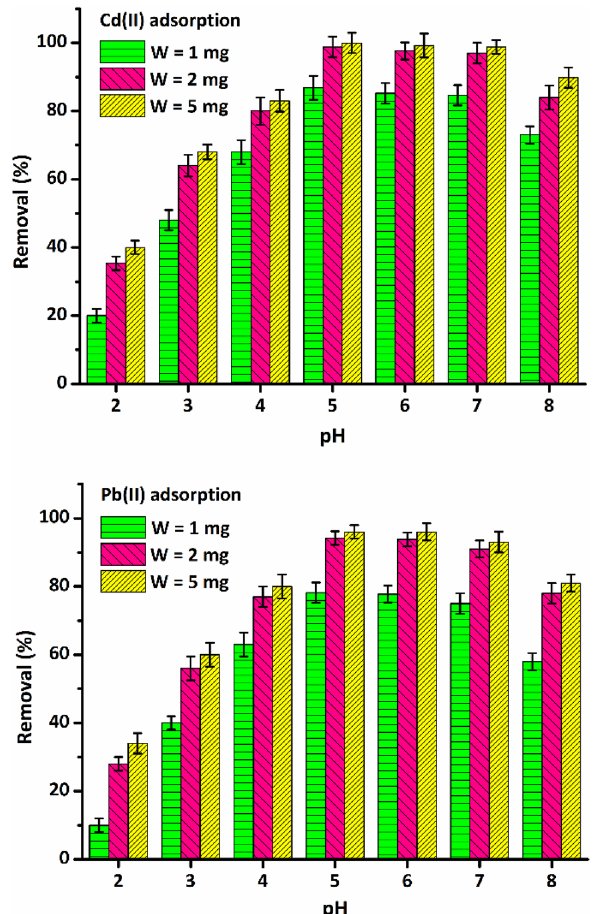
Figure 6. The effect of pH and adsorbent dose on the removal performance of the adsorbent toward Cd(II) and Pb(II) cations ( V =20 mL, C i = 25 mg L −1 , t = 120 min, T = 25 ℃ , shaking speed 200